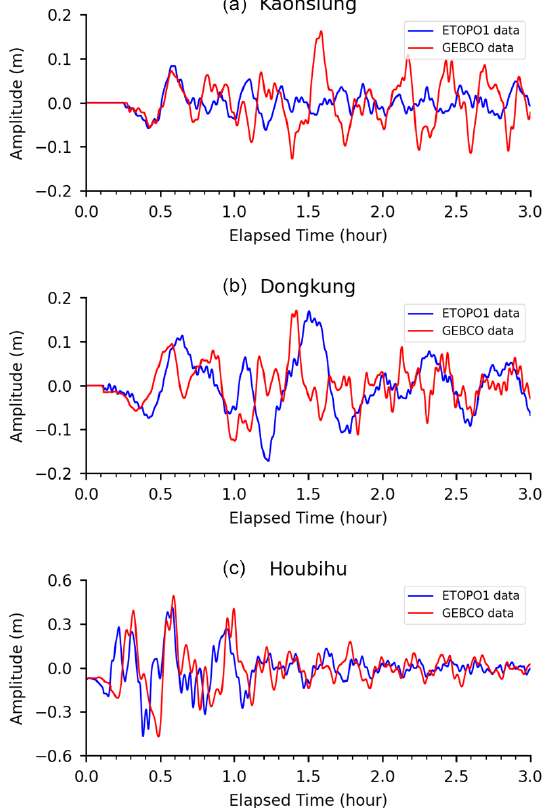
Figure 20. Simulated tsunami waveforms at the (a) Kaohsiung, (b) Dongkung, and (c) Houbihu stations using two different open- source bathymetry datasets, GEBCO and